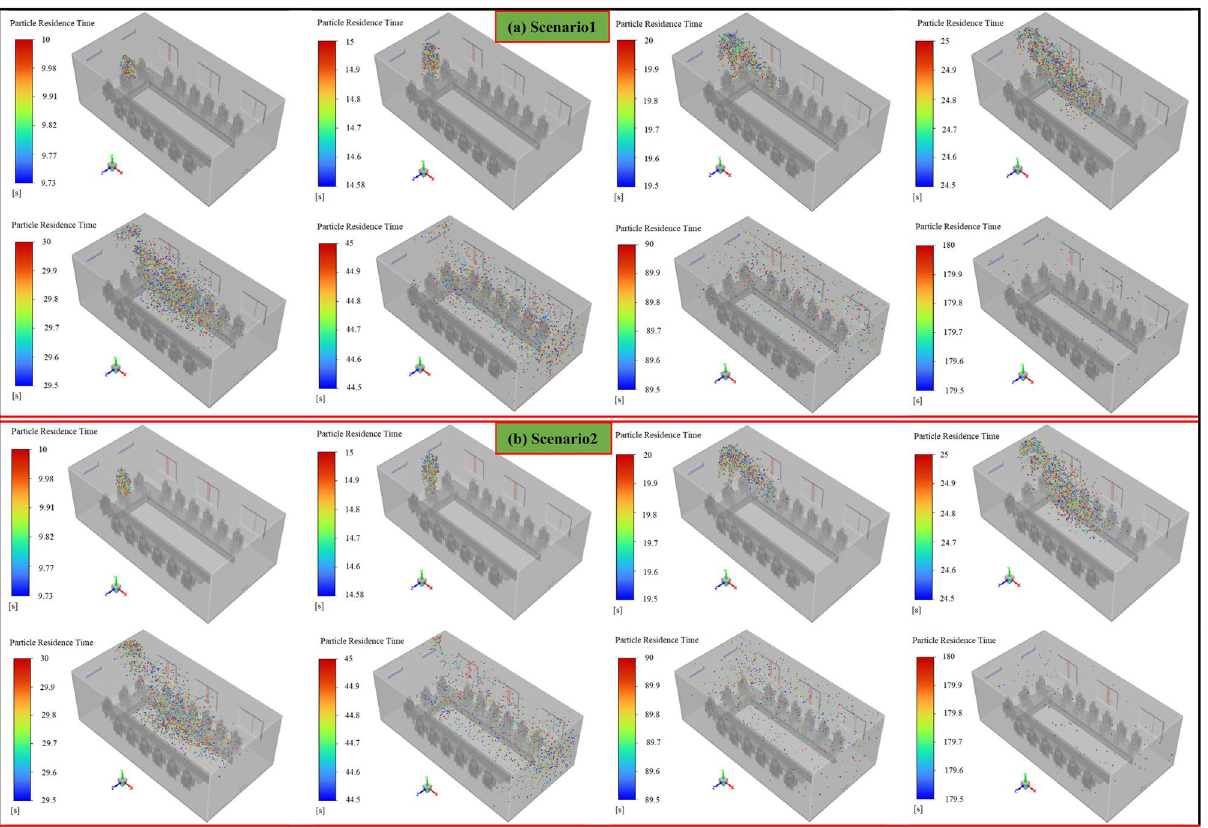
Figure 14. Aerosol cloud profiles at eight instances of time (10–180 s) inside the meeting room for different scenarios: ( a ) scenario 1, ( b ) scenario 2, ( c ) scenario 3, and ( d ) scenario